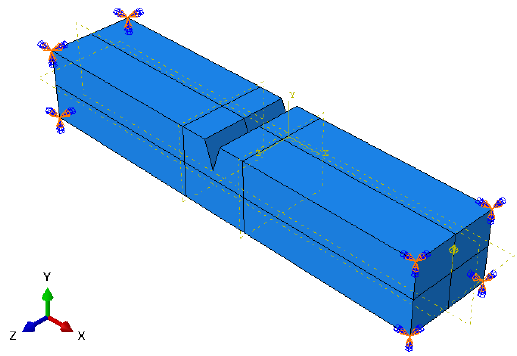
Figure 9. Boundary condition of FEM model.